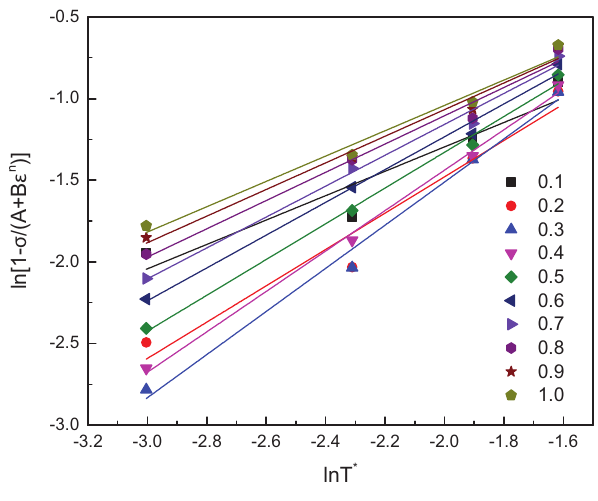
Figure 5: Relationship between ln 1 − σ = A + B ε n ð Þ½ (cid:2) and ln T * .